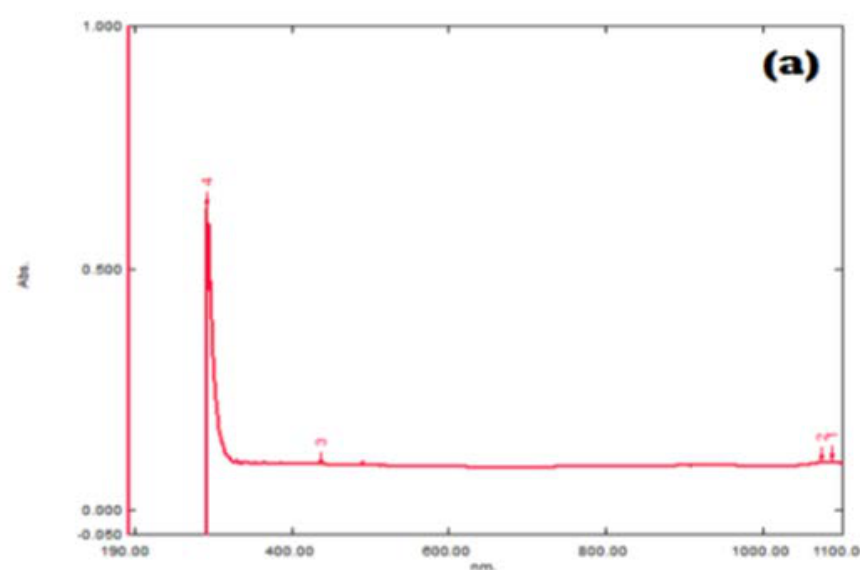
Fig.3: The UV ــ VIS absorption spectra of S-WCNTs DI water, suspension at volume fraction 13 x10 -5 .